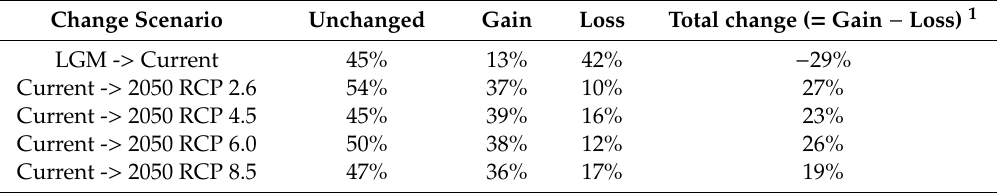
Table 5. Predicted changes in the climatically suitable habitat area of T. c. carolina under varying climate scenarios within their distribution range. Abbreviations: Last Glacial Maximum (LGM) and Representative Concentration Pathway